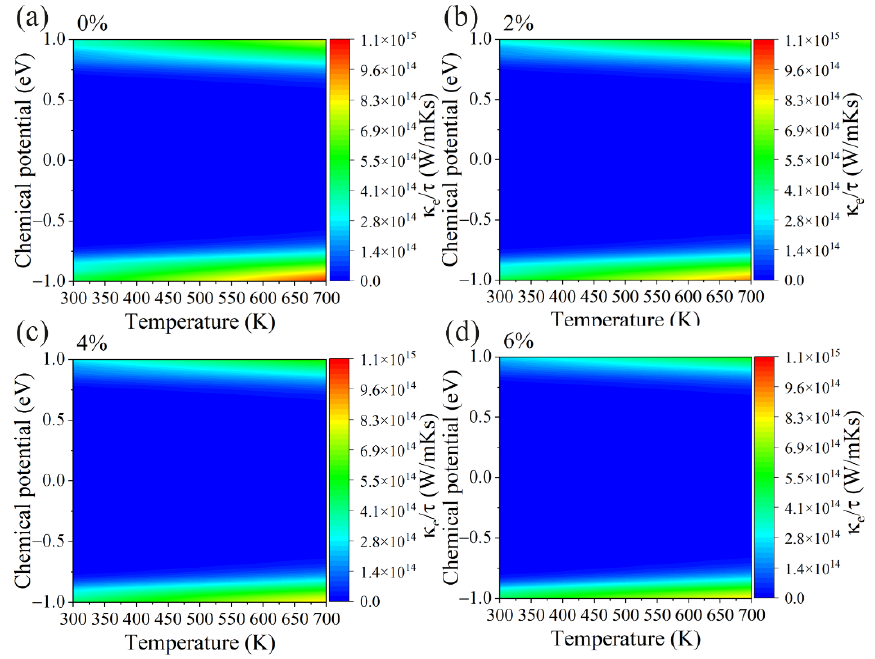
Figure 6. The contour map of the electronic thermal conductivity divided by relaxation time ( κ e / τ ) with respect to chemical potential under different biaxial tensile strains of ( a ) 0%, ( b ) 2%, ( c ) 4% and ( d ) 6% for GeS 2 monolayer.